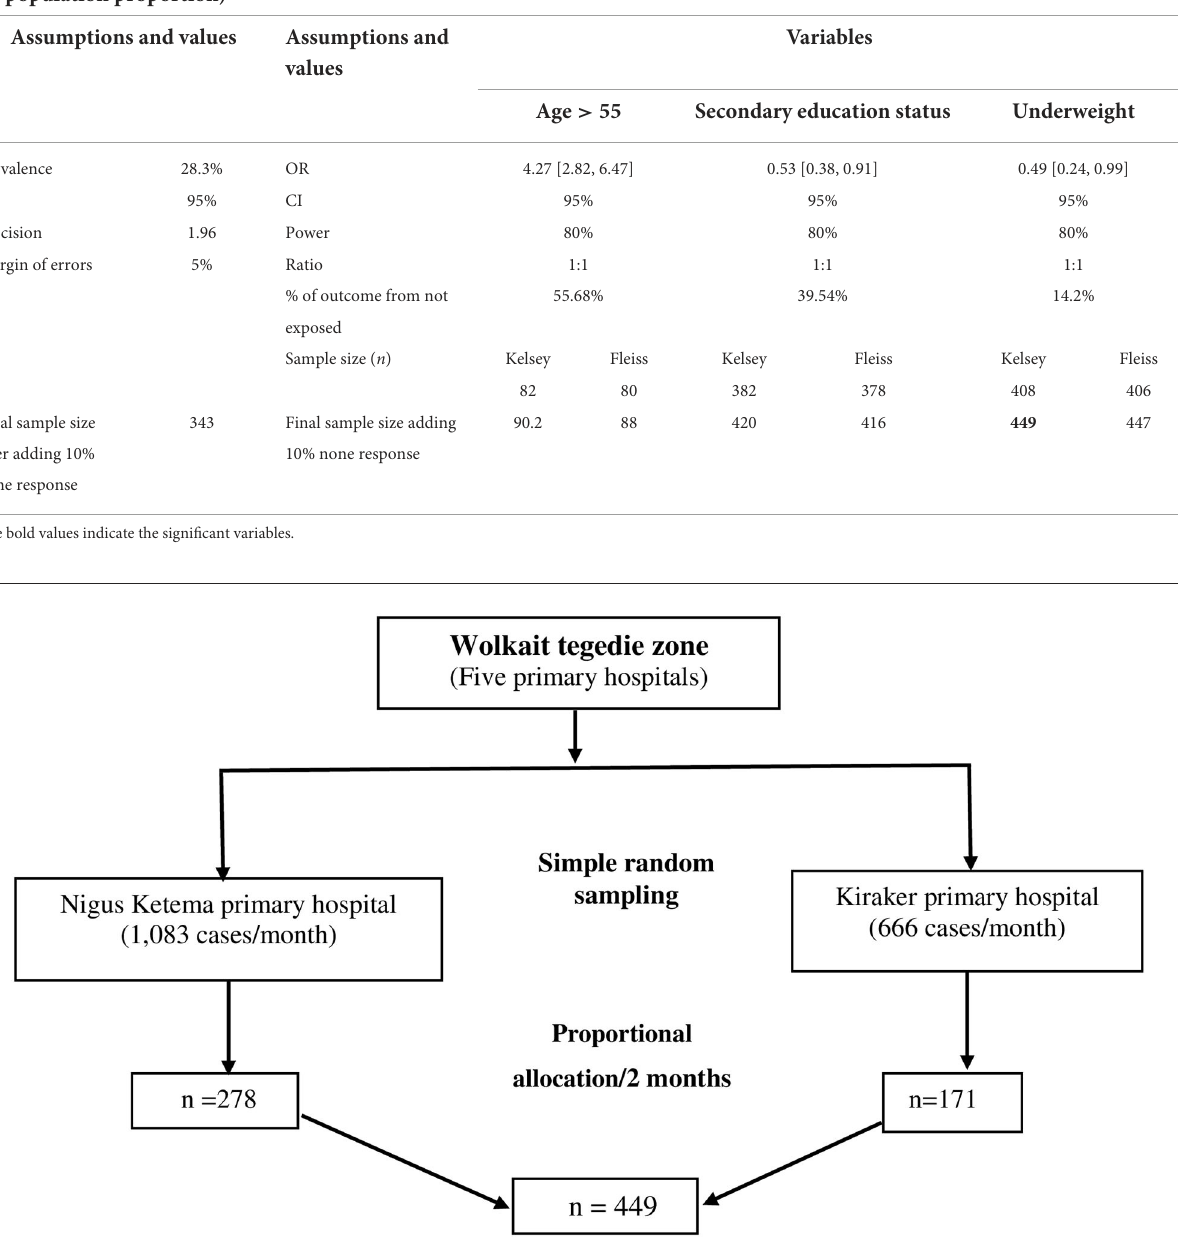
FIGURE1 Sampling producers for the study of prevalence and associated factors of hypertension among adult patients evaluated at the OPD in the Kiraker and Nigus Ketema primary hospitals, Northwest Ethiopia,